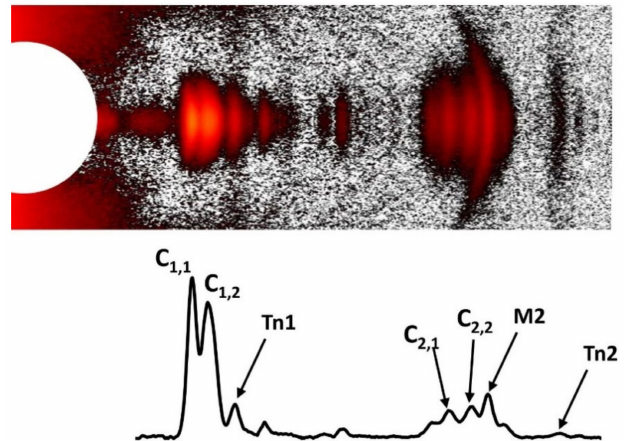
Figure 5. The M1 and M2 clusters in the meridional pattern (see reference [75]). The M1 and M2 clusters are located around the expected positions of the M1 and M2 “forbidden” meridional reflections. C 1,1, C 1.2 and C 2,1 , C 2,2 are doublets assumed to correspond the first order and second order MyBP-C reflections, respectively. Tn1 and Tn2 are the first and second order troponin meridional reflections, respectively. In this example, the M1 forbidden myosin reflection is not resolved and only the M2 is